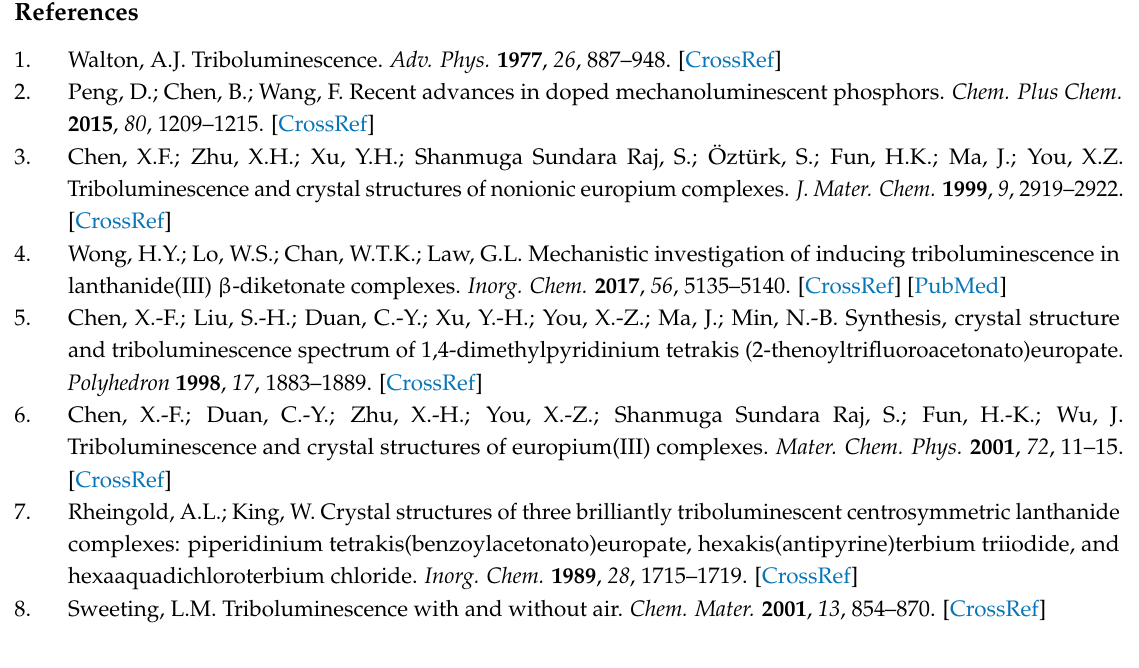
Figure S1–S17 and Table S1: Spectra of characterization and photophysical measurement, crystallographic